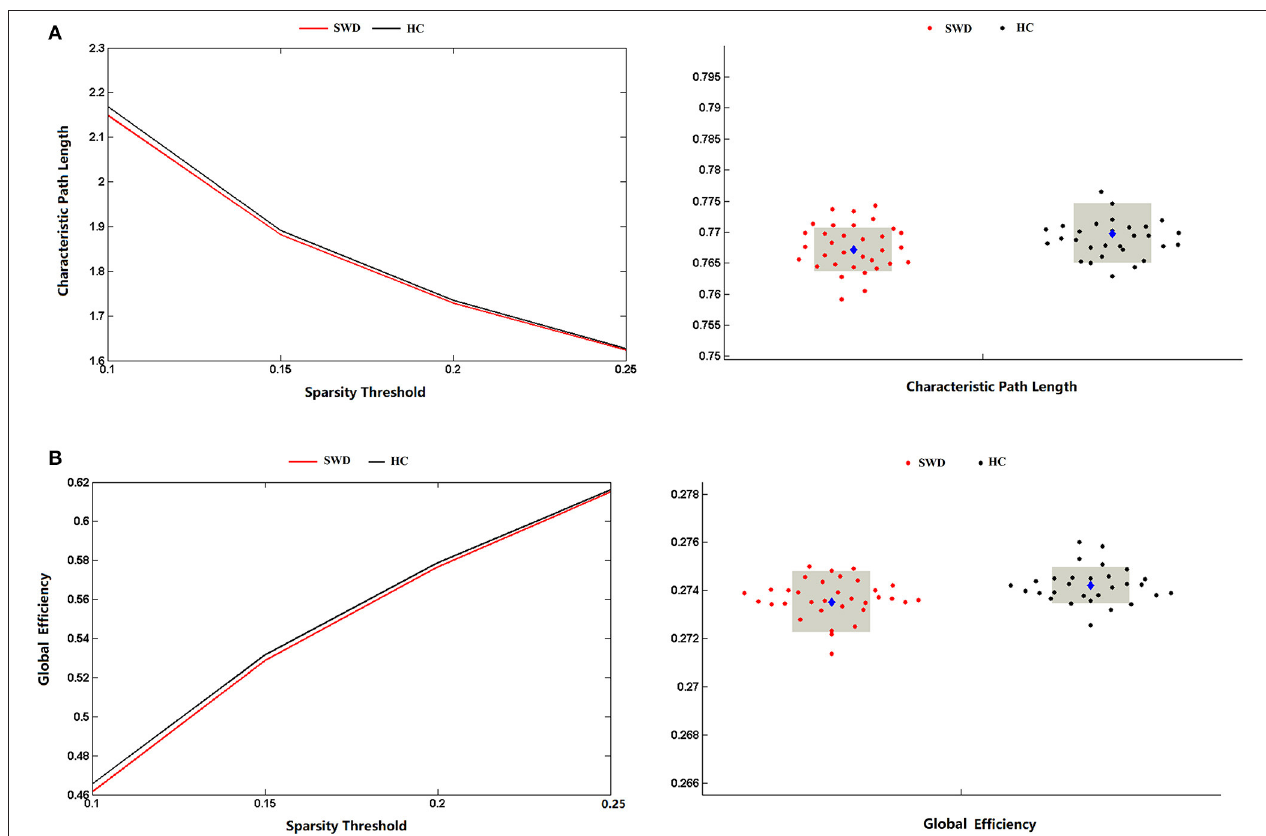
FIGURE 4 | Group comparison of global network topological properties (Lp and Eg) between the patients with SWD and healthy controls. (A) The Lp values of the patients with SWD had a significant reduction in contrast with HCs on certain sparsity thresholds (0.1 ≤ Sp ≤ 0.25). (B) The result revealed that the patients with SWD exhibited notably lower Eg than the HCs on certain sparsity thresholds (0.1 ≤ Sp ≤ 0.25). Eg, global efficiency; HC, healthy control; Lp, characteristic path length; SWD, shift work